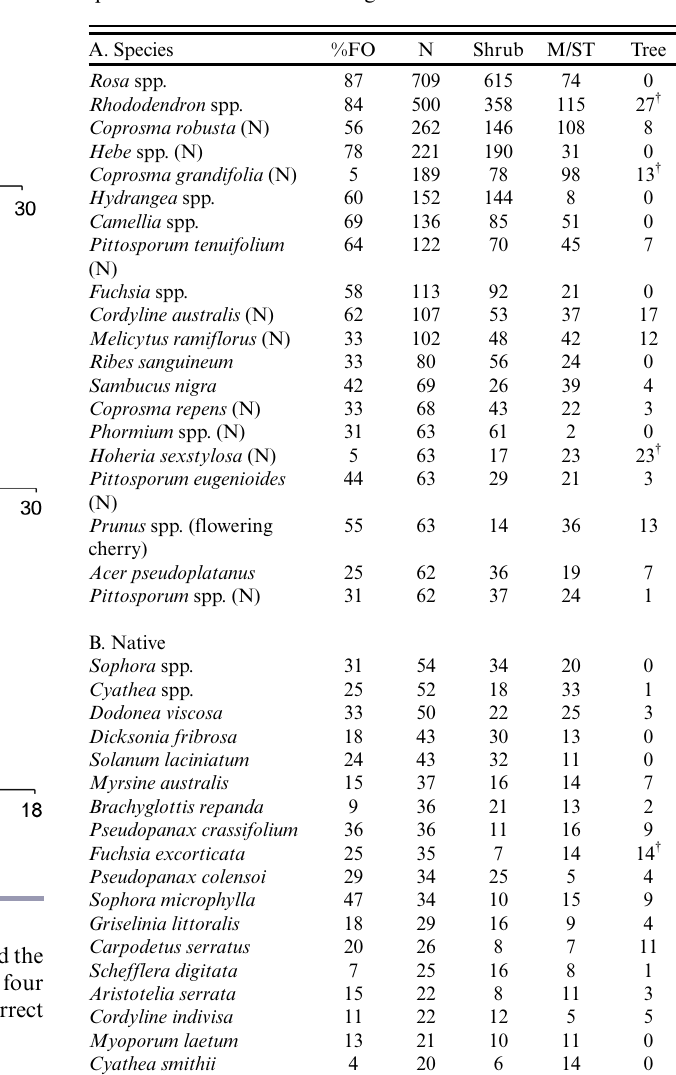
Table 2 . Total number (N), number within each height tier, and frequency of occurrence across gardens (%FO) of (A) the 20 most abundant species overall (N = native), and (B) native woody species occurring at least 20 times. S = shrub 0.5 - 2 m; M/ST = multi/single stemmed tree 2 - 5 m; T = Tree > 5 m. † > three- quarters occur in one or two